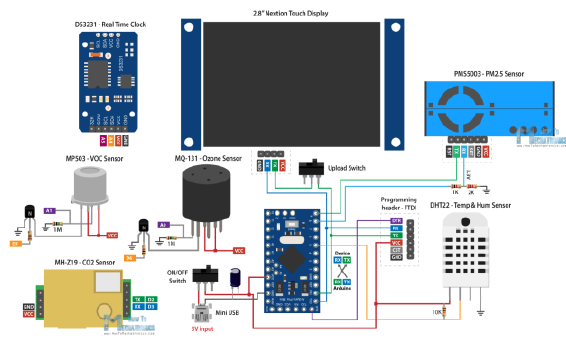
Figure 7. Schematic overview of component assembly of the air quality device using the Arduino Mini Pro [8]